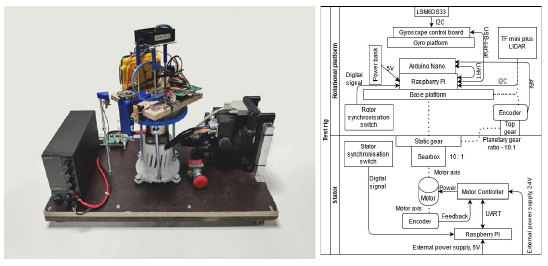
Fig. 3. Schematics of the end switches. Left: mechanical alignment, right: electrical schematic.